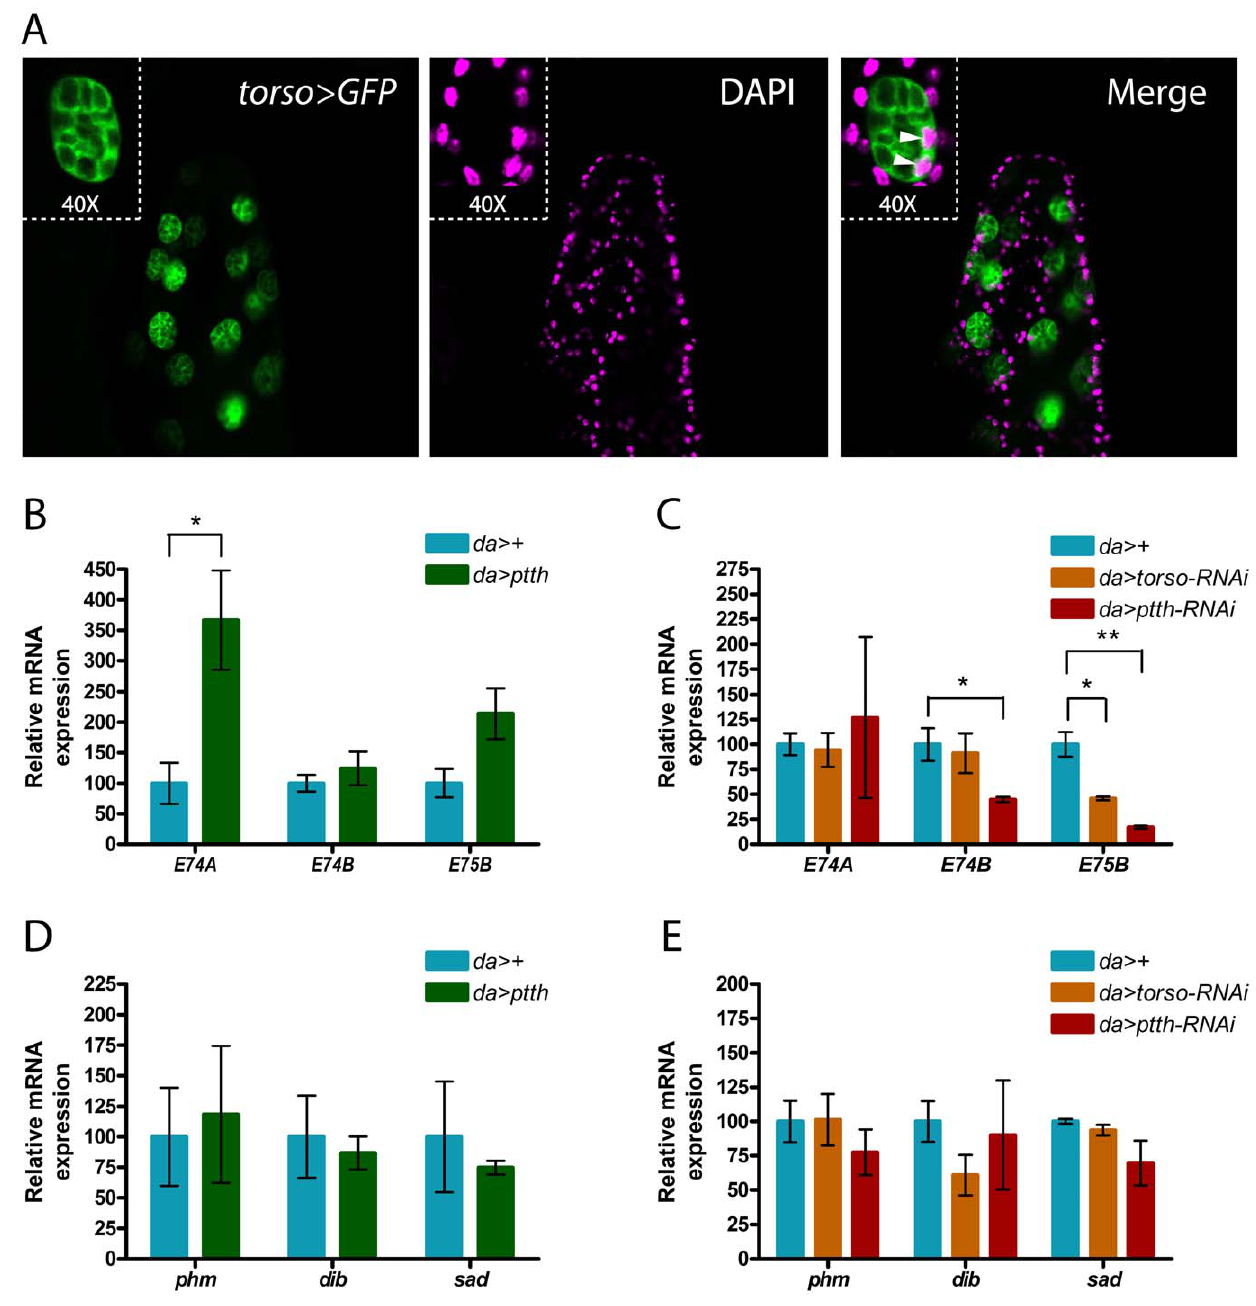
Figure 4. Adult ecdysteroid levels are regulated by PTTH that may target the accessory glands in Drosophila . (A) GFP expression driven by a torso-Gal4 line in the bi-nucleated secondary cells of a male accessory gland of Drosophila . Inserts are magnifications showing the two nuclei of spherical secondary cells. Green: GFP, Magenta: DAPI. (B-E) Gene expression was analyzed by qPCR in adult Drosophila males overexpressing ptth ( da . ptth ) and in animals with reduced expression of torso ( da . torso-RNAi ) or ptth ( da . ptth-RNAi ). da . + ( da . crossed to w 1118 , genetic background used by VDRC for generating the RNAi lines) was used as a control and expression was normalized to rpL23 mRNA levels. (B and C) Ecdysteroid levels estimated as levels of expression of ecdysteroid target genes E74A, E74B and E75B . (D and E) Expression of Halloween genes phm, dib and sad